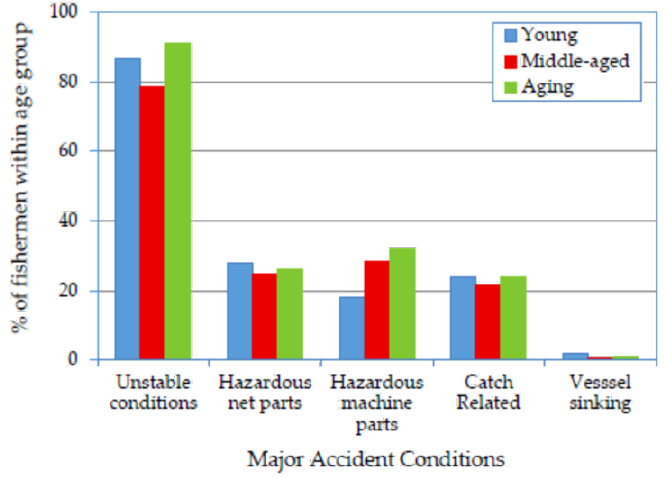
Figure 3. Prevalence of major accident conditions reported by fishermen according to age group.